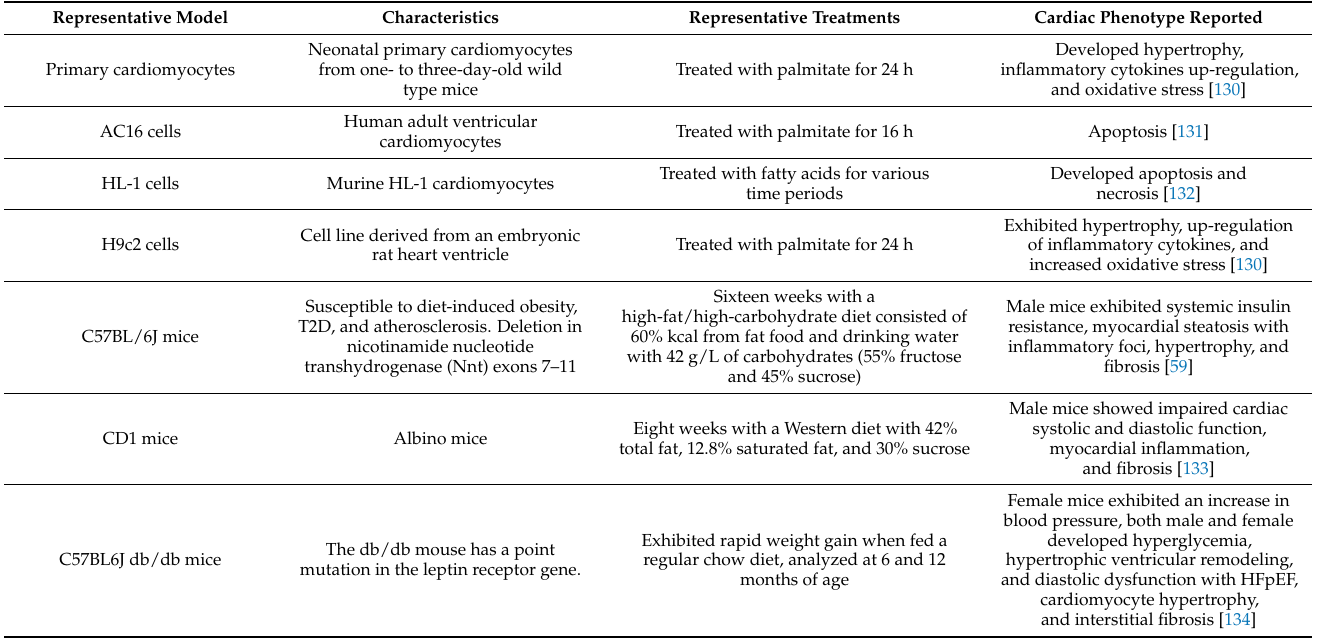
Table 3. Cell lines and animal models of